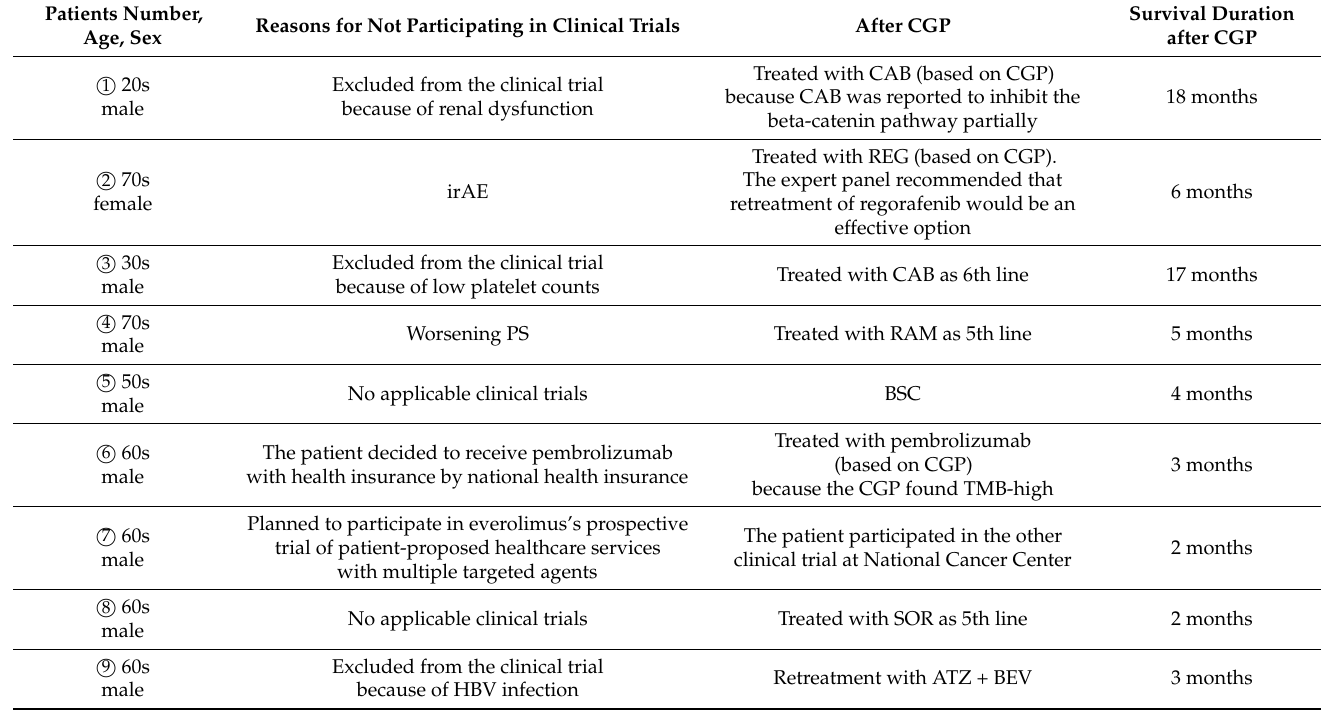
Table 3. Clinical outcome after comprehensive genomic profiling